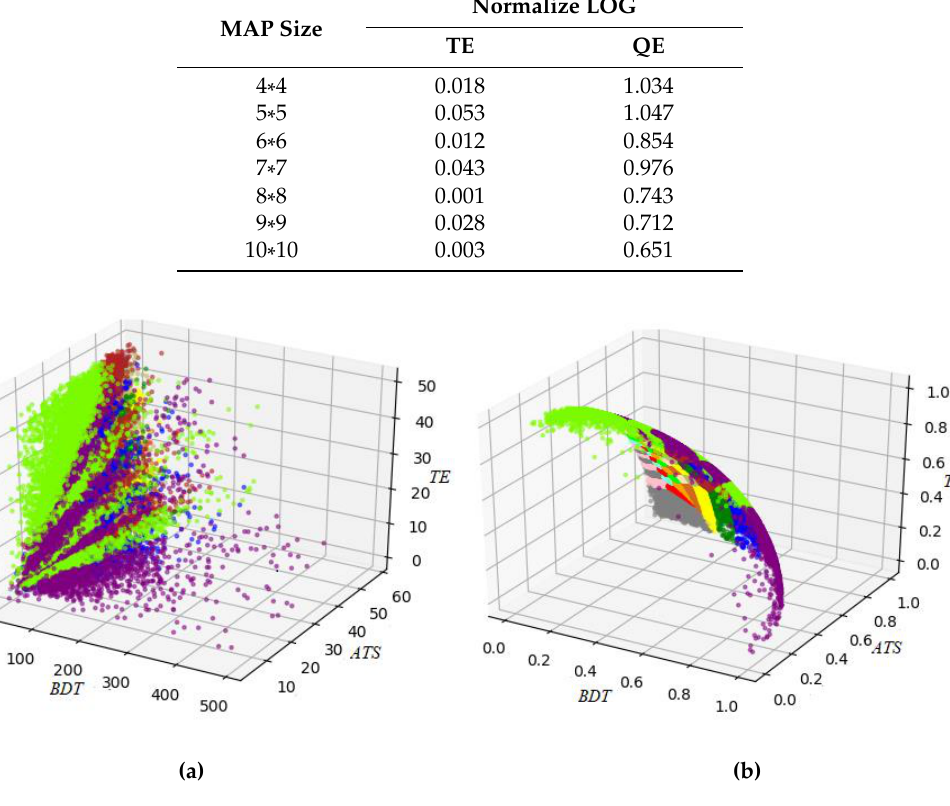
Table 6. Results of the congested RSB estimation (top five values of CI SOM ).